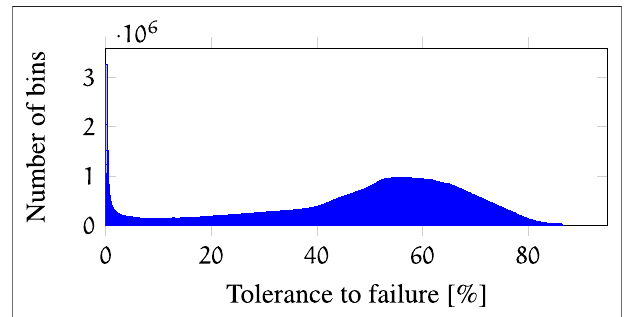
FIGURE 5 | Histogram of bin values of all mapped poses ξ in W f .